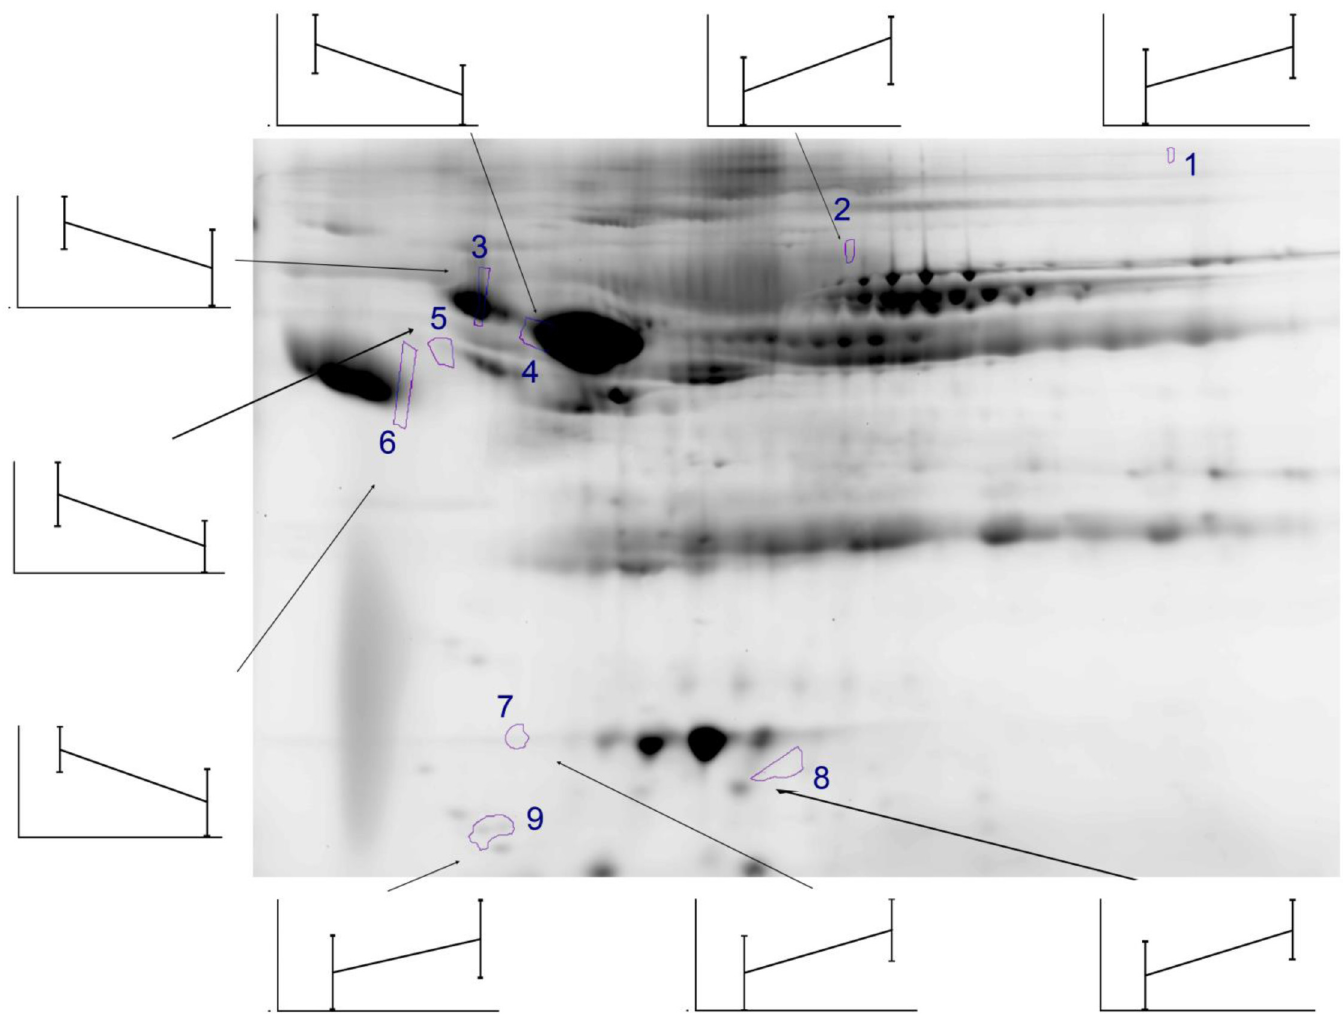
Fig 2. Reference gel of plasma proteins dysregulated by IPA. Shown is a reference gel of 2DE of SEC fractionated and IgY depleted plasma proteins from the study subjects. The location of 9 spots, identified as candidate discriminant proteins are shown. Spot #1 is FIBB; #2 is ALBU; #3 is AATL; #4 is A1AT; #5 is LRG1; #6 is A1AG1; #7 is APO A1; #8 is FIBA; and #9 is APO C3. The image shown represents the pI range of 3 – 10 and the molecular size range of 25 – 200+ kDa. Inset, average abundance of each protein spot is shown graphically for Case (Left) and Control (Right) as shown for protein spot #